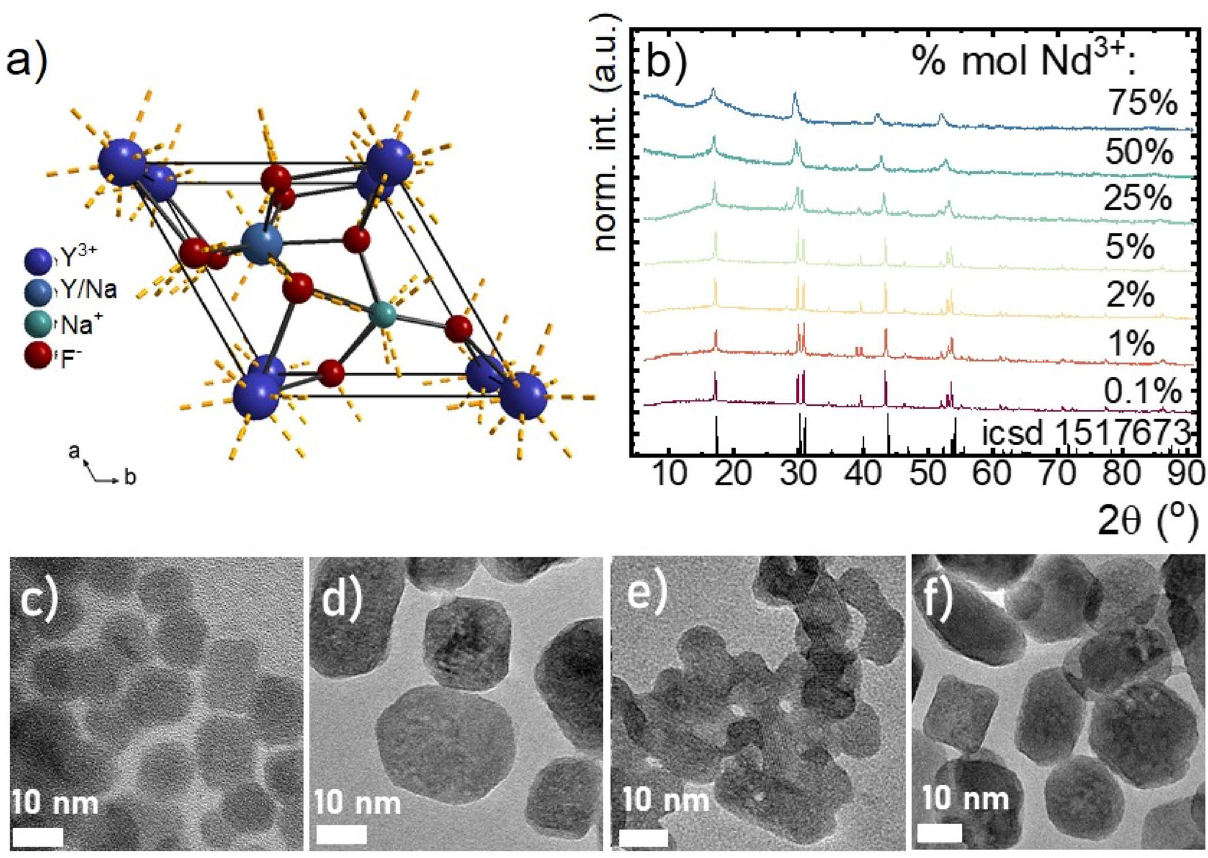
Figure 1. The visualization of the NaYF 4 crystal unit cell ( a ); X-ray diffraction patterns of NaYF 4 doped with different concentration of Nd 3+ ( b ); the representative TEM images of NaYF 4 nanoparticles doped with 1% ( c ), 5% ( d ), 25% ( e ), 75% ( f ) of Nd 3+ of the 4 F 5/2 , 2 H 9/2 → 4 I 9/2 , 4 F 7/2 , 2 S 3/2 → 4 I 9/2 and 4 F 9/2 → 4 I 9/2 electronic transitions corresponding to the emission bands at 800 nm, 740 nm and 690 nm, respectively. A shortening of the average distance between Nd 3+ ions associated with the increase in dopant concentration increases the probability of the { 4 F 3/2 , 4 I 9/2 } ↔ { 4 I 15/2 , 4 I 15/2 } cross relaxation that leads to the quenching of the emission intensity and shortening of the lifetime of the 4 F 3/2 state 42–46 . Both anti-Stokes and Stokes emission bands can be observed simultaneously (Fig. 2b,c). However, the anti-Stokes luminescence is less intense. Therefore to analyze the shape of the emission spectra both parts of the spectrum were presented separately. Although the spectral position of the emission band is independent of dopant concentration the shape of the 4 F 3/2 → 4 I 9/2 band changes significantly (see also Supplementary Figs. S2 and S3). At elevated Nd 3+ concentration the intensity of the emission lines corresponding to the R 1 and R 2 Stark levels of the 4 F 3/2 state to the Z 5 Stark component of the 4 I 9/2 level decreases due to the energy reabsorption (Supplementary Fig. S4). The metastable 4 F 3/2 state plays a crucial role in the generation of both Stokes (radiative depopulation of 4 F 3/2 state) and anti-Stokes (as a platform for thermalization of higher laying states) luminescence of Nd 3+ ions. Therefore it is important to analyze the influence of the Nd 3+ ions concentration on the lifetime of the 4 F 3/2 state. As shown in Fig. 2d the exponential luminescence decay profile can be found for low dopant concentration and an increase in Nd 3+ amount results in a deviation from exponential shape due to the cross relaxation process. Therefore to perform a qualitative analysis the average lifetime was calculated as follows: